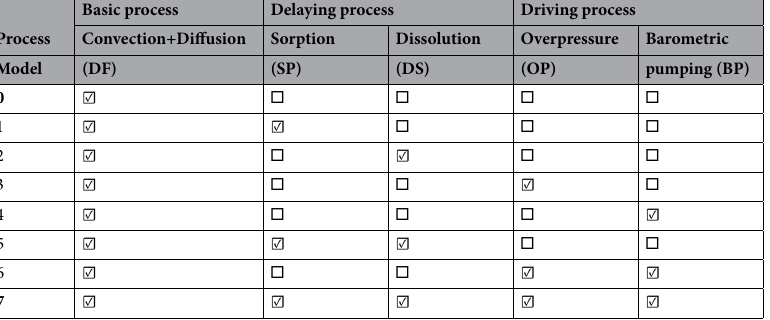
Table 3. Deterministic models with multiple physical processes (including basic processes of geothermal- gradient induced multiphase convection and